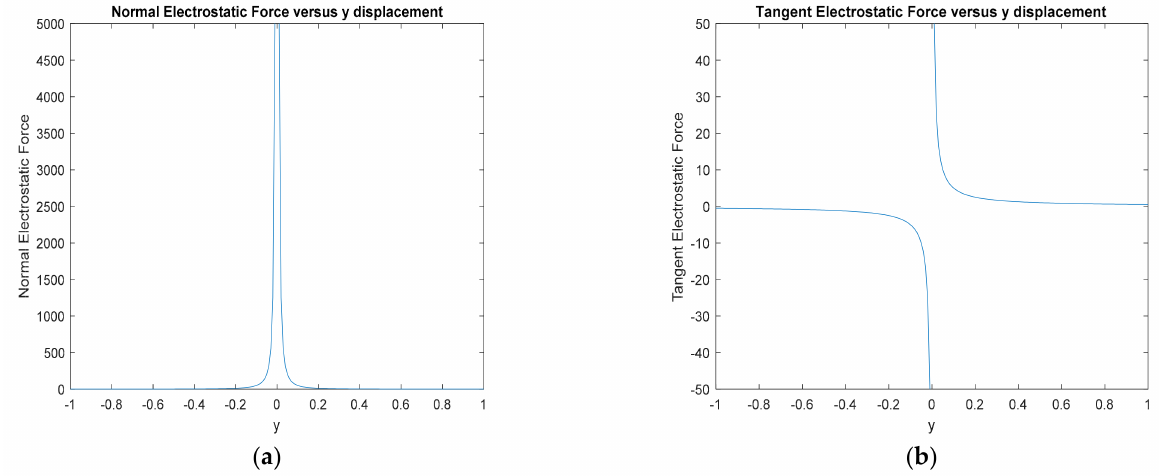
Figure 19. (Above) ( a ) Graph of the Electrostatic normal force with respect to changes in distance between the electrodes ( b ) graph of the Electrostatic tangent force with respect to changes in distance between the